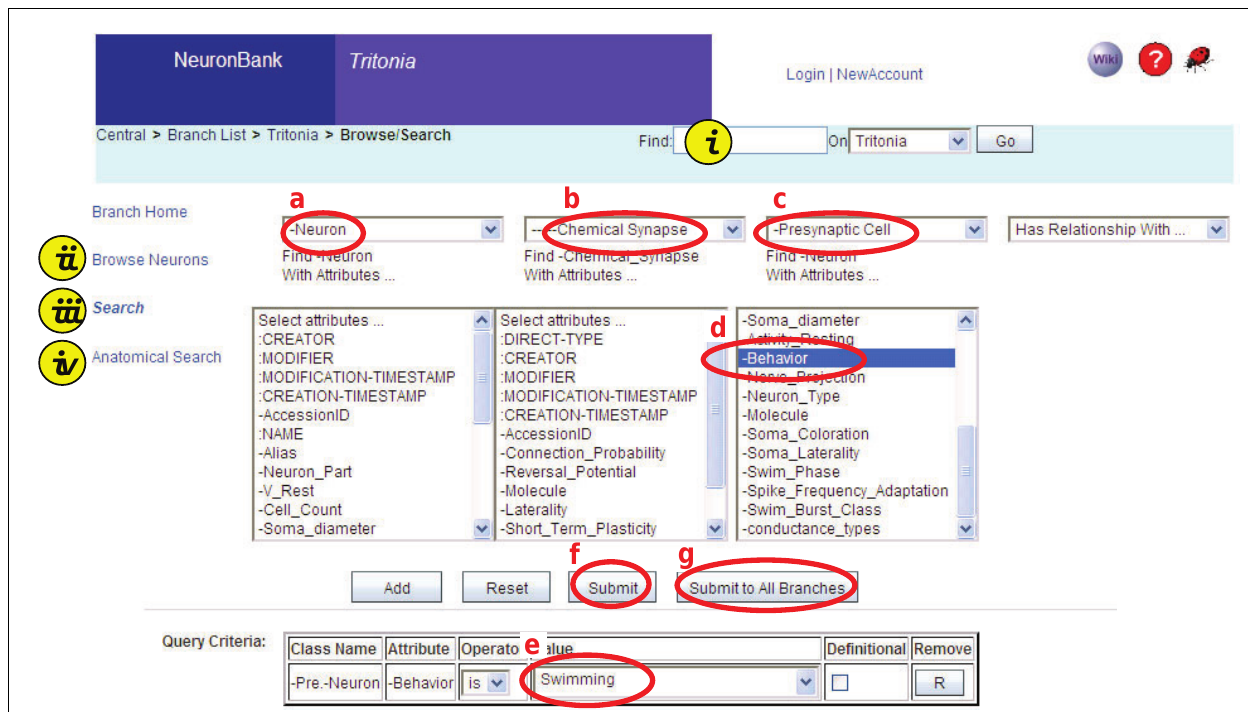
FIGURE 5 | Screen shot of a search on the Tritonia branch. Four types of searching are available i. Text string, ii. Browsing, iii. Form-based search, iv. Anatomical search. In a form-based search shown, the user has created a query for a neuron (a) with a chemical synapse (b) where the presynaptic cell (c) has an attribute of “- behavior” (d) and the value of that attribute is “Swimming” (e). This query can be submitted to the Tritonia branch (f) or it can be submitted to all branches